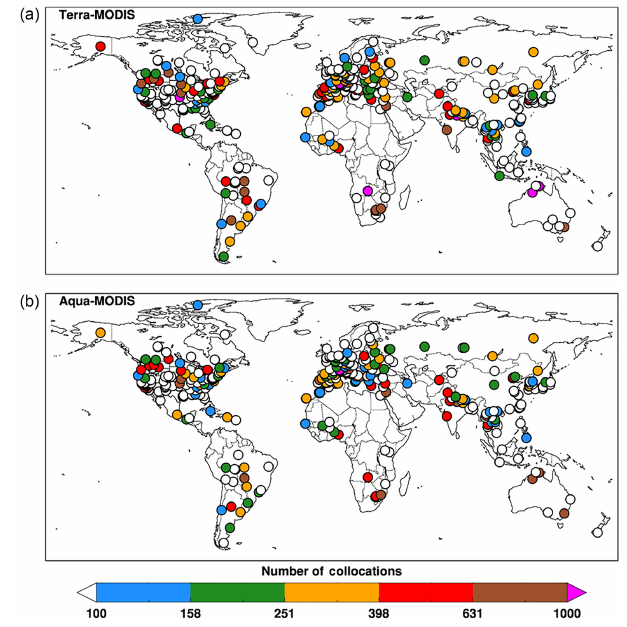
Figure 1. Locations of AERONET stations used in the validation study. The color scale shows the number of coincident MODIS– AERONET data points over each station for the entire period. Panel (a) is for Terra MODIS and panel (b) for Aqua MODIS. Most sta- tions operated for only a subset of the 13- to 15-year